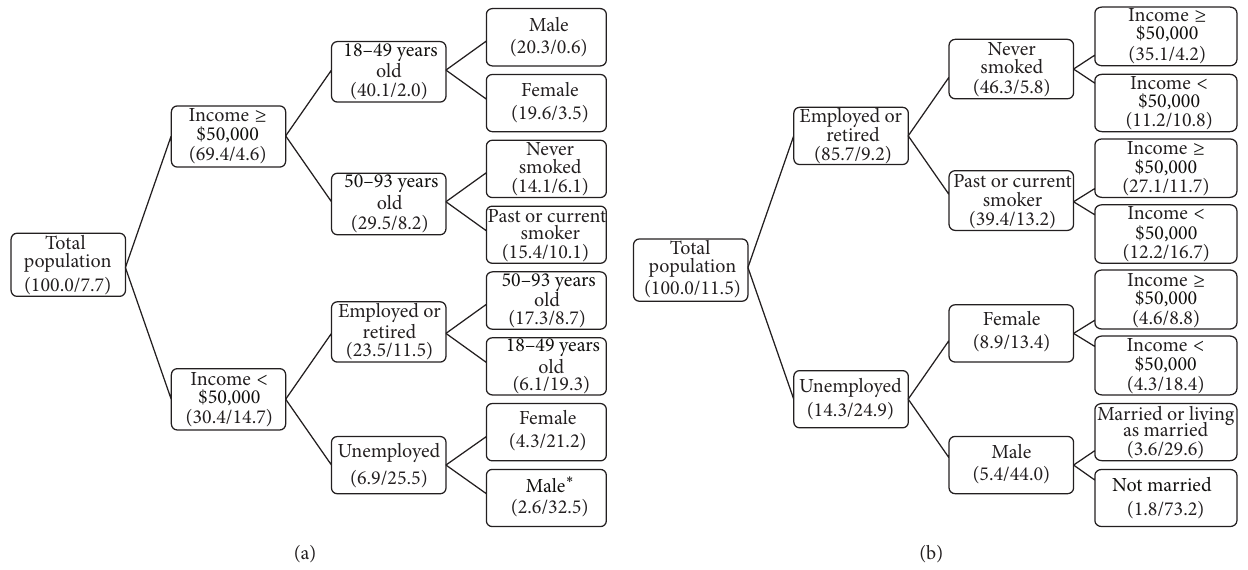
Figure2:Decisiontreeanalysis-percentofpopulationineachsubgroupandthepercentwithneuropathicpainwithintherespectivesubgroup ( 𝑁 = 26, 423, 339 ). (a) Probable or possible neuropathic pain condition and screening positive on the SLANSS (Self-Report Version of the Leeds Assessment of Neuropathic Symptoms and Signs). Risk estimate (standard error) = 0.077 (.004). (b) Probable or possible neuropathic pain condition and screening positive on the DN4 (Douleur Neuropathique 4). Risk estimate (standard error) = 0.106 (0.000). Numbers in brackets represent % of total population and % with neuropathic pain within that subpopulation e.g., ∗ Male (2.6/32.5) = 32.5% of males who were unemployed with an annual income < $50,000 reported neuropathic pain and this represents 2.6% of the total population of Canada. All findings have an adjusted 𝑝 value < 0.001. Growing method was